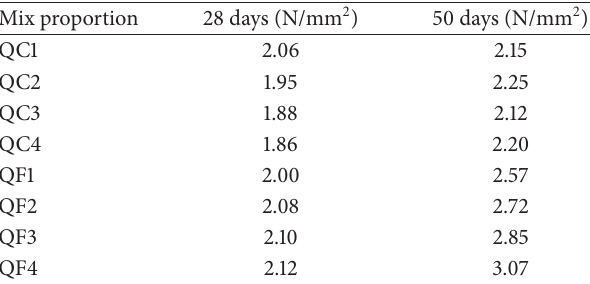
Figure 7: Compressive strength test results. Table 10: Transverse strength test result.